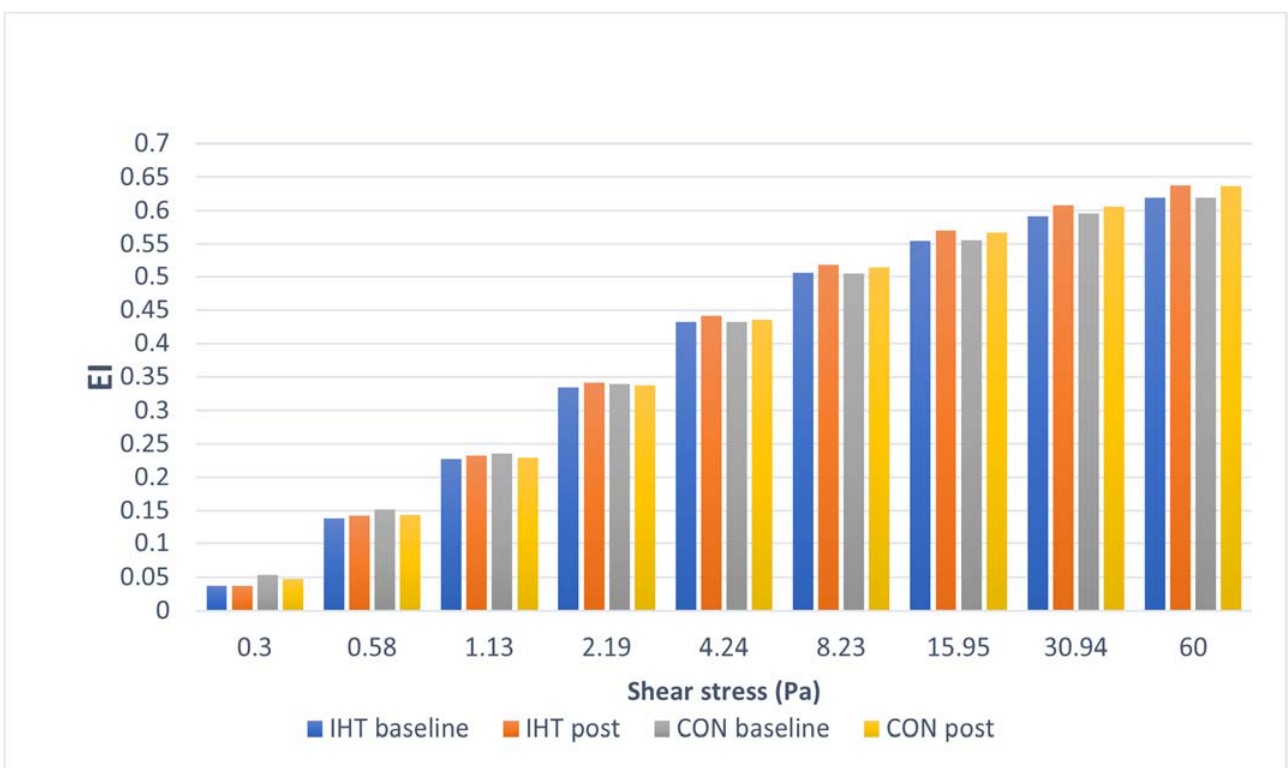
rowers training in the hypoxia (intermittent hypoxic training, IHT) and normoxia (control, CON)